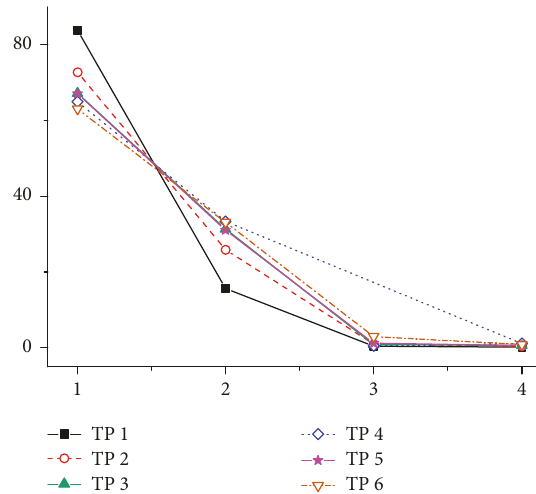
Figure 2: Word length distributions across six time periods (The abscissa represents word length and the ordinate represents percent- age of word tokens).